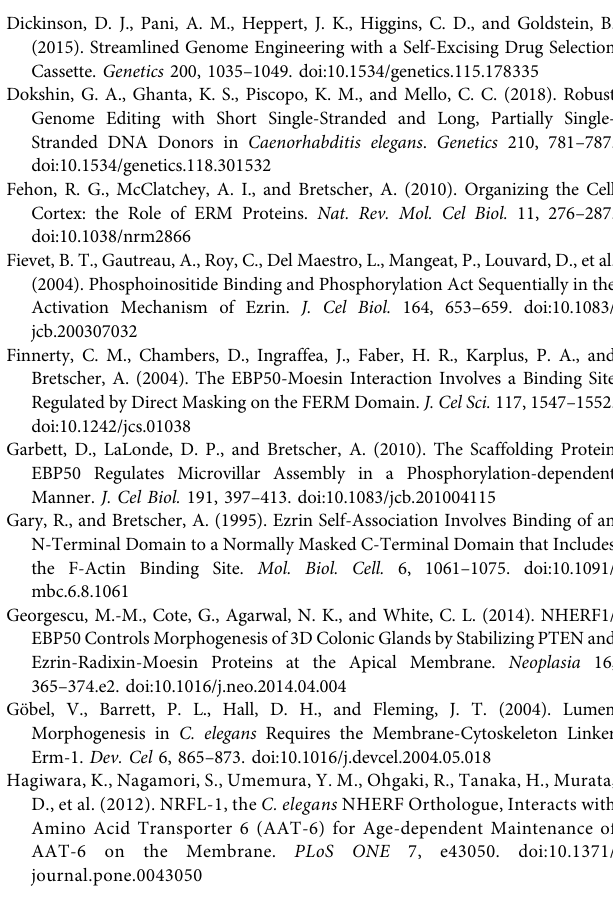
Supplementary Figure S1 | NRFL-1 is recruited to the apical domain by ERM-1 in different tissues. (A) Schematic representation of the domain organization of C. elegans NRFL-1, D. melanogaster Sip1 and H. sapiens NHERF1/EBP50 and NHERF2. Percentages above the domains represent the similarity between that domain and the corresponding domain of NRFL-1. For the single PDZ domain of Sip1, two percentages are presented corresponding to each NRFL-1 PDZ domain. In the EB domain alignment, amino acids that are important for the interaction with ERMproteinsareshowninred(Terawakietal.,2006).PDZ (cid:1) Post-synapticdensity- 95, disks-large and zonula occludens-1; EB (cid:1) ERM binding. Supplementary Figure S2 | Lumen discontinuities in nr fl -1 and erm-1 single and double mutants. (A) Representative images of the intestine in L2 larvae of the indicated genotypes expressing YFP::ACT-5 as an apical marker. (B) L1 larvae carrying the apical marker YFP::ACT-5 of the indicated genotypes fed with Texas- RedDextran.Theorangearrowheadindicatestheconstrictionthatpreventsthe fl ow of fl uorescent dye along the intestine. All images are taken using a spinning-disk confocal microscope, and a single focal plane is shown. Supplementary Figure S3 | Validation of the speci fi city of the α -pERM for T544 phosphorylated ERM-1. (A,B) Representative images of fi xed animals stained with antibodies recognizing the junctional protein DLG-1 ( α -DLG) and phosphorylated ERM-1 ( α -pERM). (A) shows erm-1(+) and erm-1[T544A] larvae and (B) shows the intestine of wild-type 2.5-fold embryos that are untreated (-PP) and treated with protein phosphatase (+PP). All images are taken using a spinning-disk confocal microscope, and maximum intensity projections are